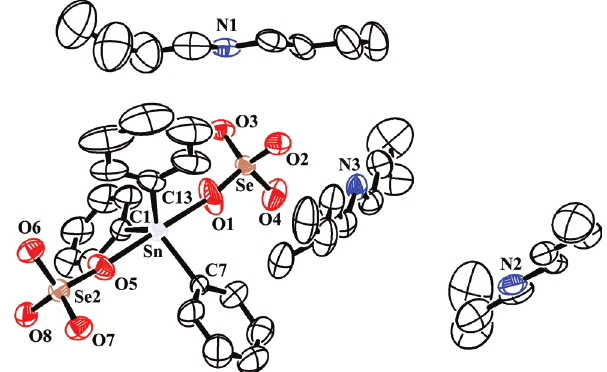
NH ] [SnPh (SeO ) ] ( 1 ) 2 2 3 3 4 2